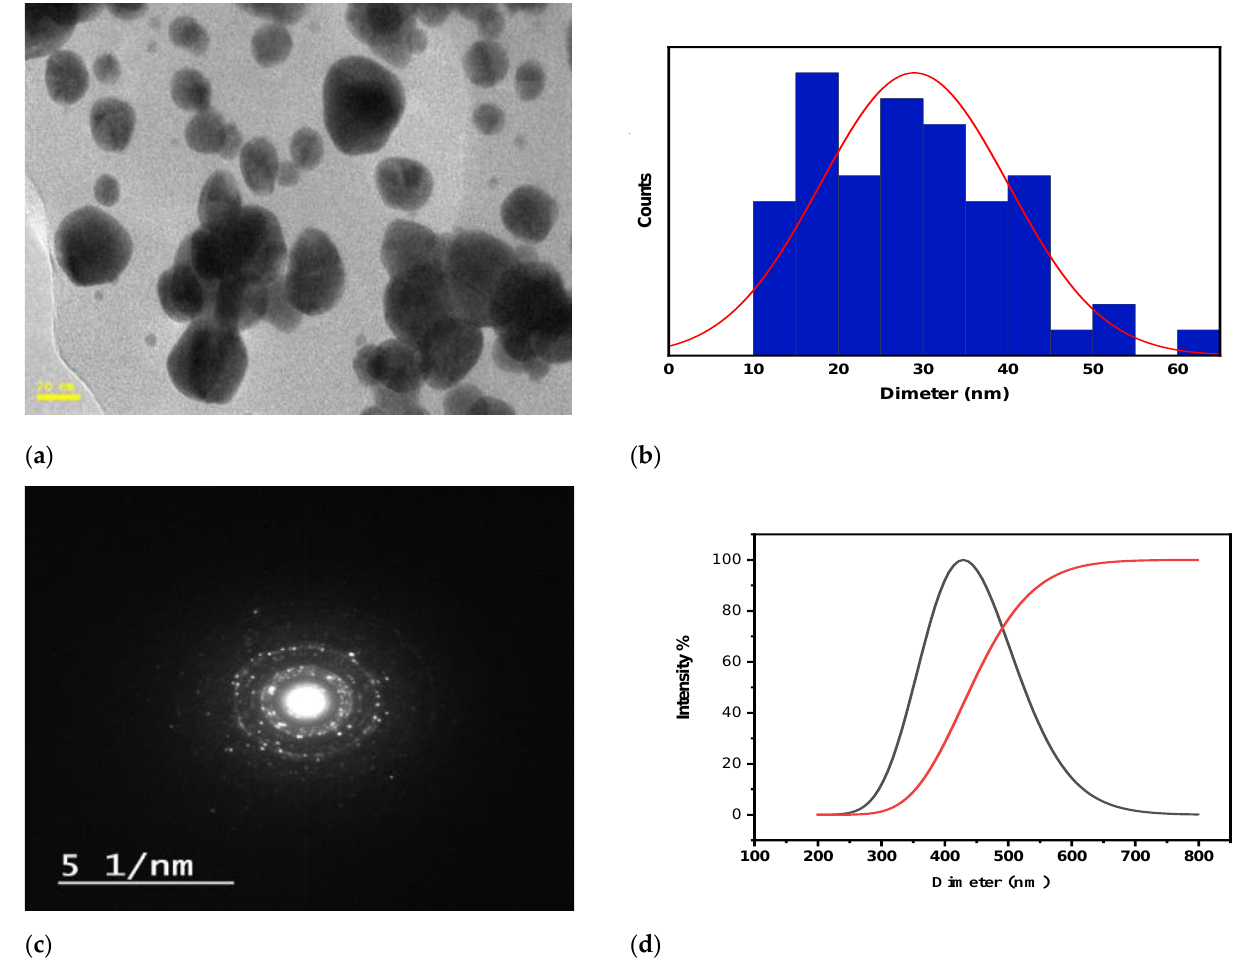
Figure 5. ( a ) HRTEM images of Cu nanoplates at different magnifications, ( b ) particle size distribution calculated from TEM, ( c ) SEAD pattern of nanoparticles, and ( d ) DLS particle size distribution.